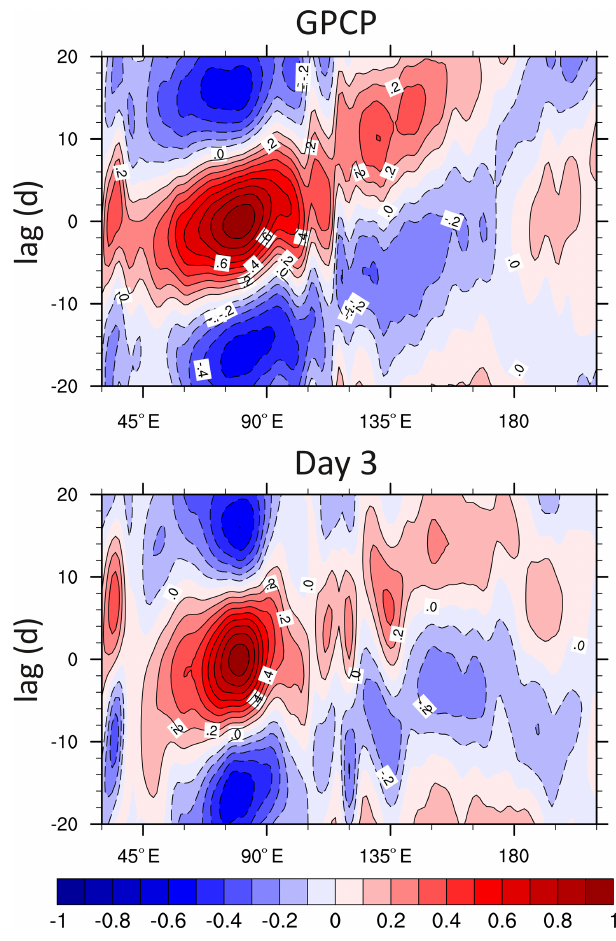
Figure 6. Time–longitude anomalous rainfall correlation Hov- möller diagram along the Equator (10 ◦ S–10 ◦ N) based on GPCP and day 3 hindcasts. The rainfall anomalies associated with the MJO are derived based on lag correlation over an Indian Ocean box (5 ◦ S–5 ◦ N, 75–85 ◦ E) for northern winter (November–April) of 1997 to